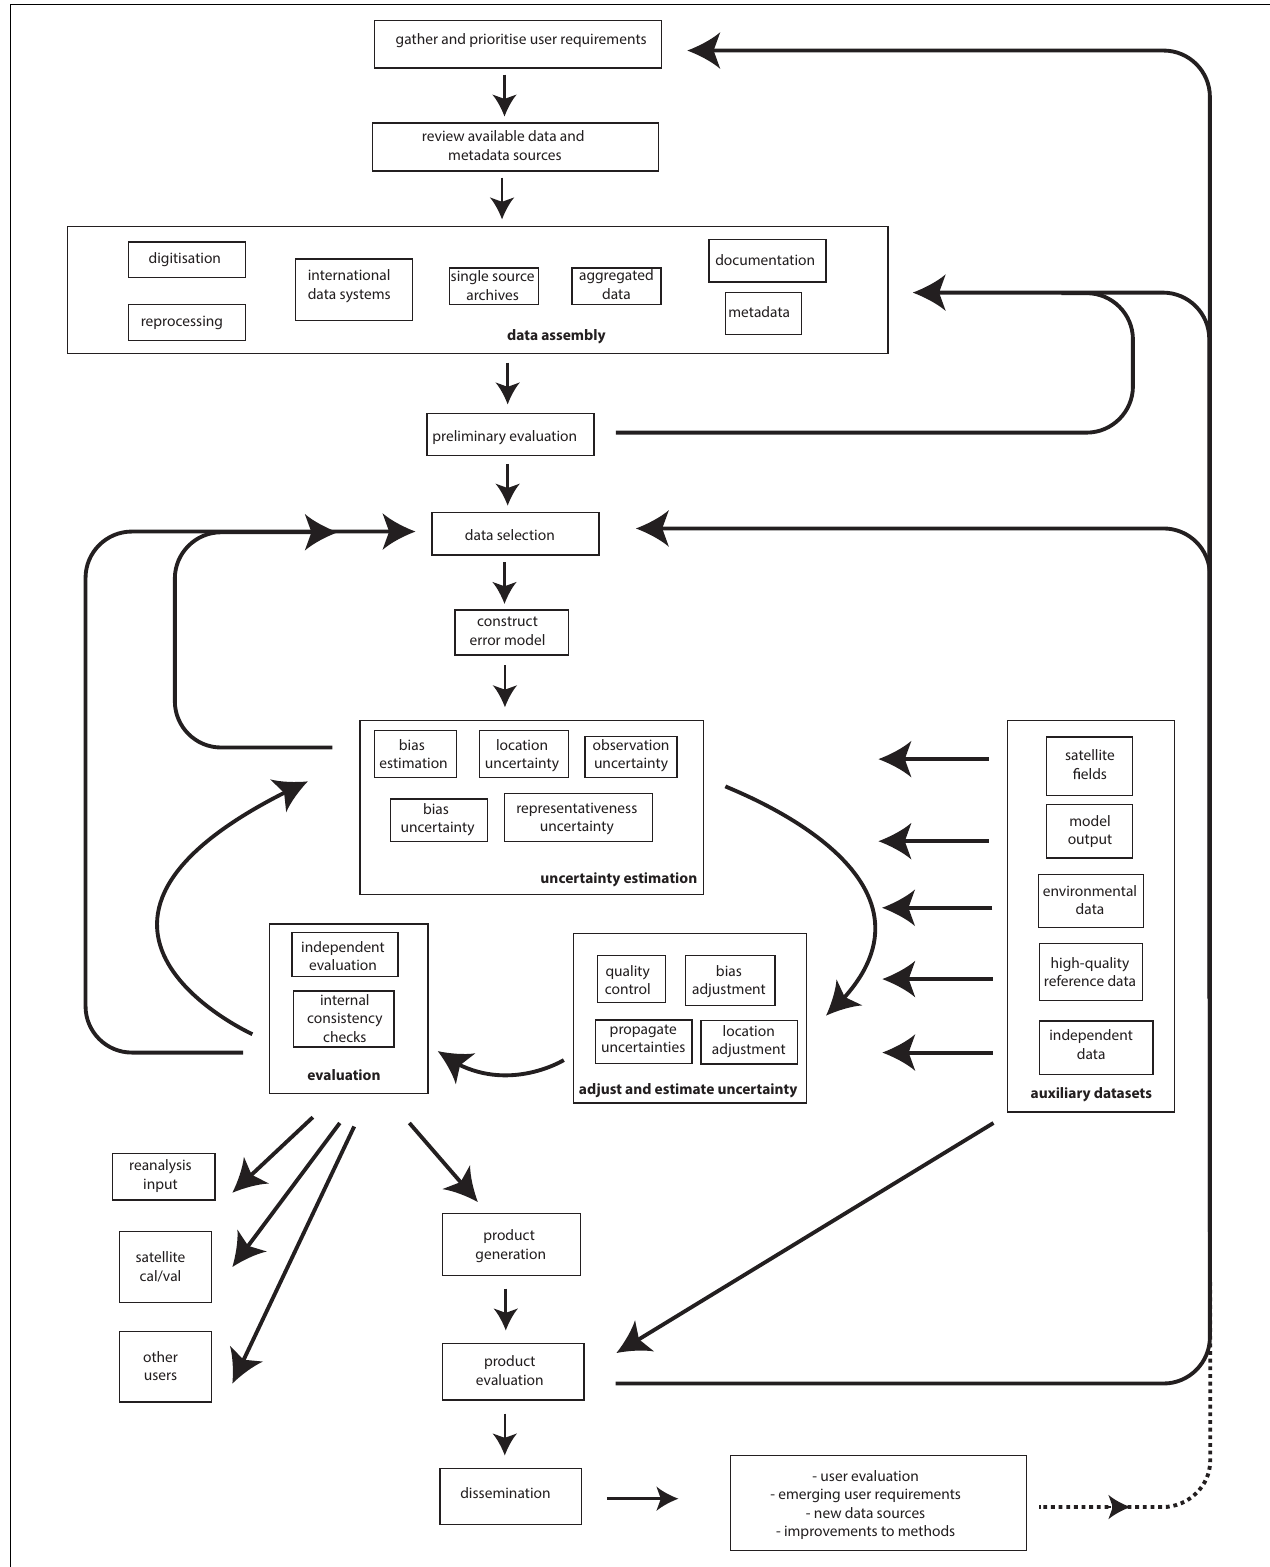
FIGURE 1 | Schematic of the development of in situ -based CDRs and other climate data products.